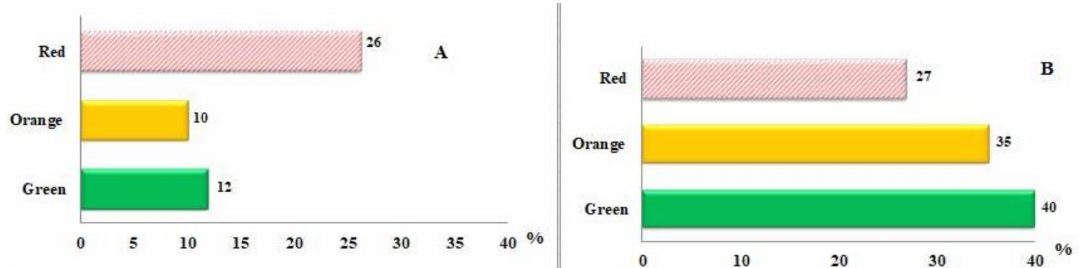
Figure 2. ( A ) The Percent (%) of (all-E)- lycopene based on total carotenoids in R. rugosa hips at different ripening degrees. ( B ) The Percent (%) of (Z)- lycopene based on total carotenoids in R. rugosa hips at different ripening